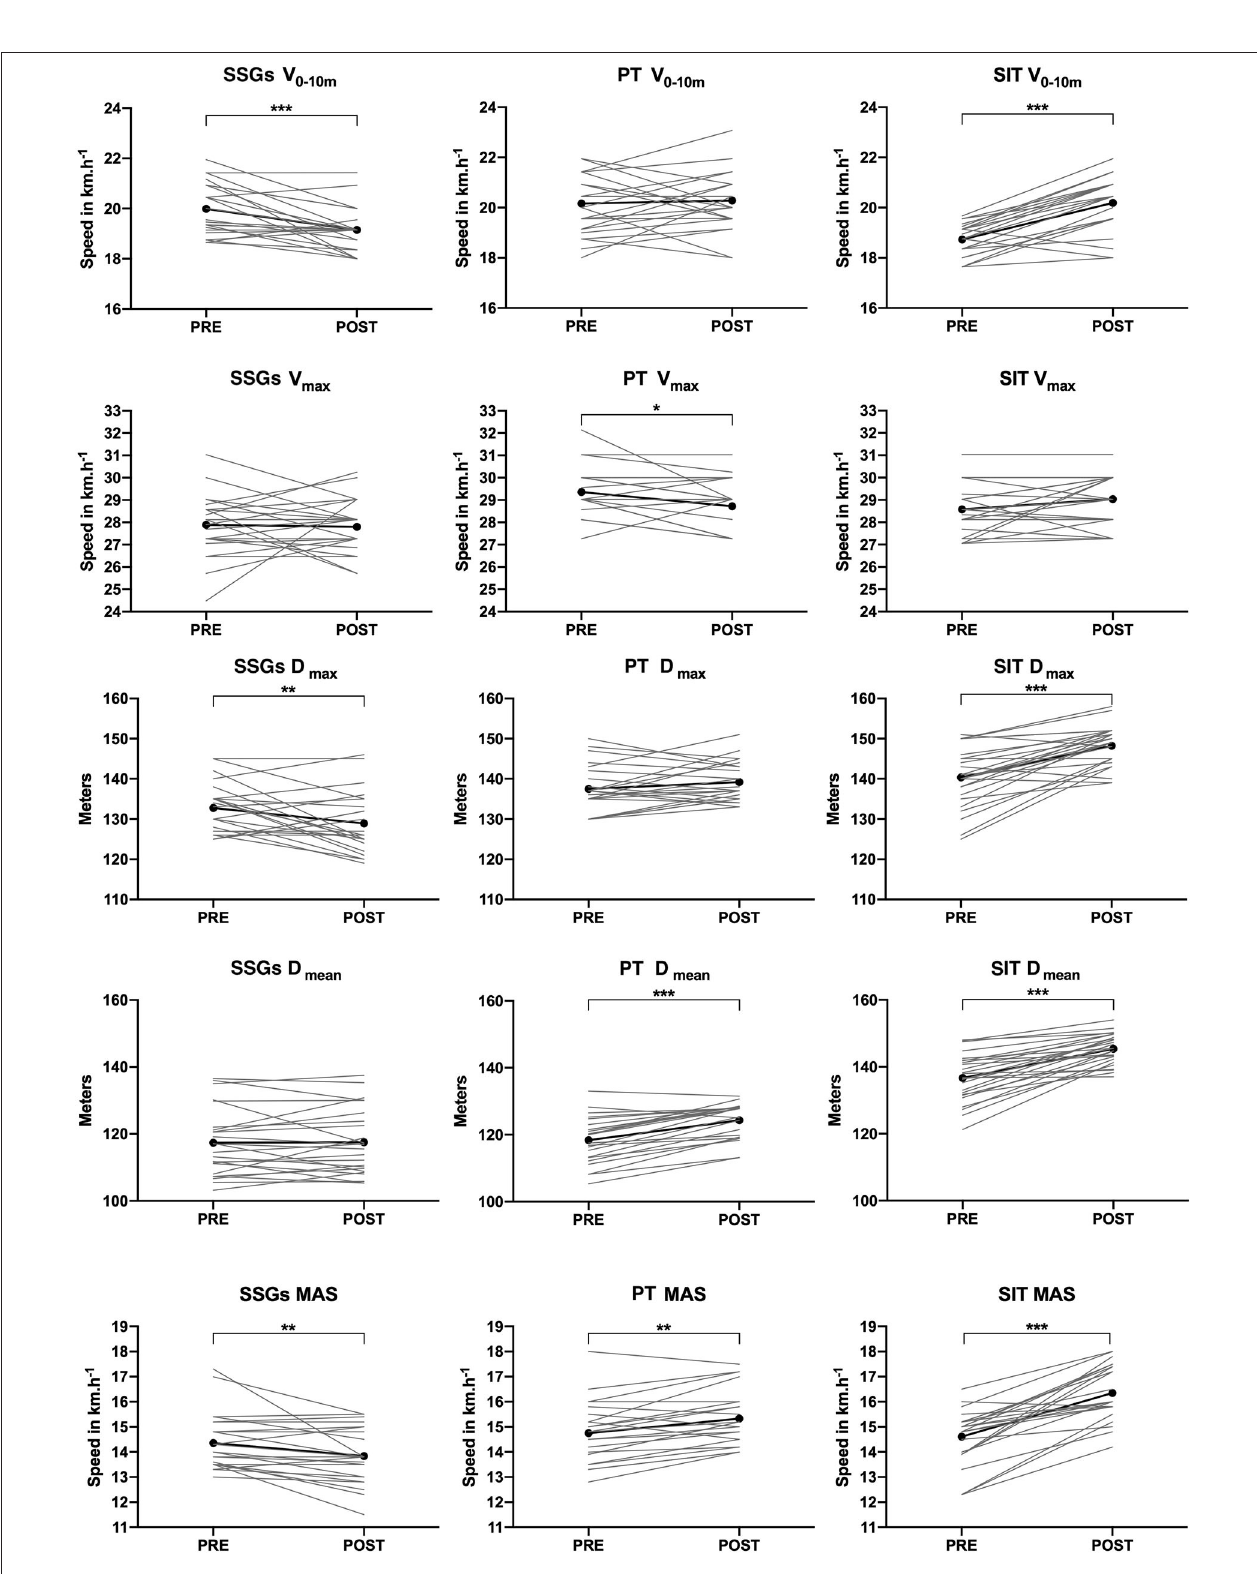
FIGURE 2 | Individuals and mean PRE-POST variations in all parameters. SSGs, small-sided games; PT, plyometric training; SIT, sprint interval training. V 0 − 10m : maximal speed from 0 to 10m; V max : maximal sprint speed reached during the 30-m trip; P max : peak power output; P mean : mean power output; MAS: maximal aerobic speed. * p < 0.05; ** p < 0.01; *** p < 0.001.